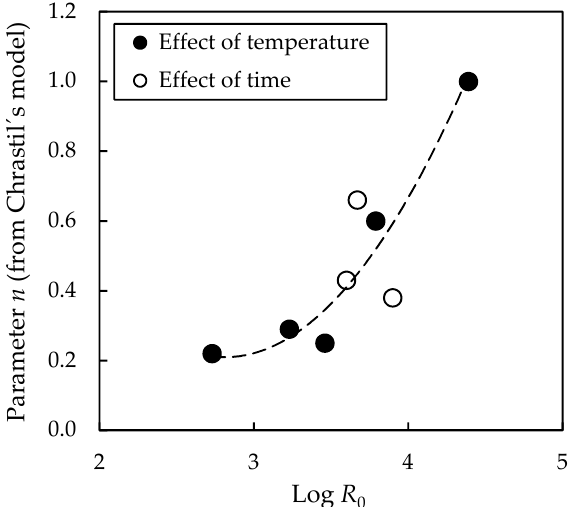
Figure 3. Effect of LHW pre-treatment severity parameter (Log R 0 ) on the parameter n of the Chrastil’s model.